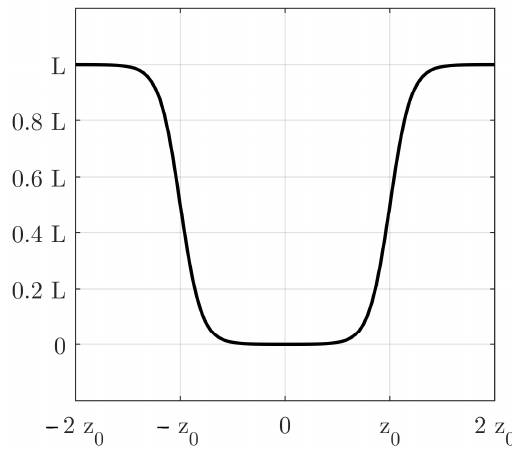
Figure 1. Modified logistic